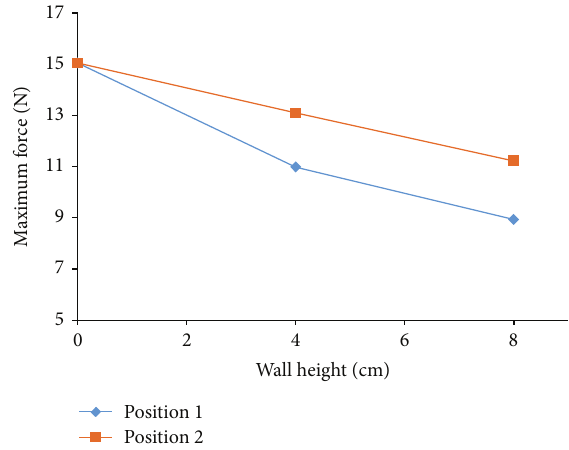
Figure 4: Changes of maximum forces with sea wall